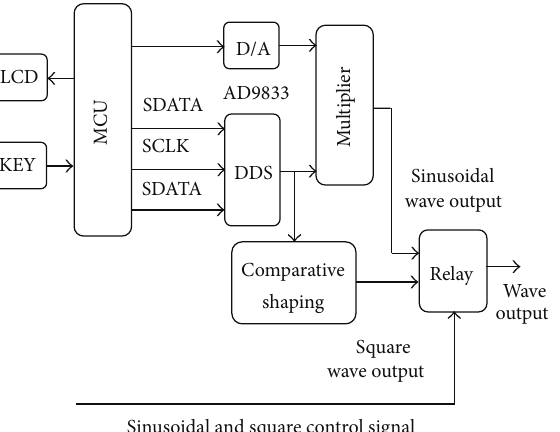
Figure 2: Block diagram of the signal generator based on